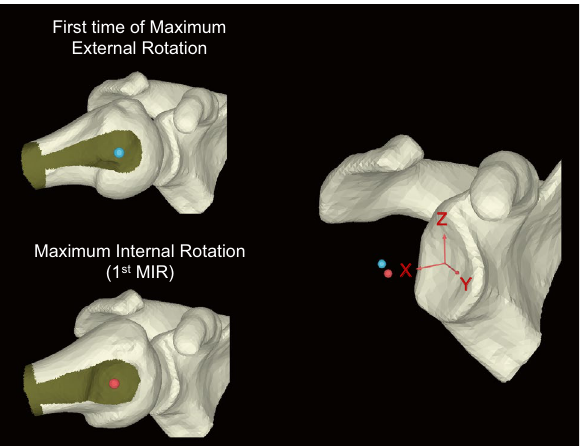
Figure 2. Coordinate system for the direction of translation of the joint contact area and humeral head centroid. Blue sphere; center of humeral head (CHH) at the original position, Red sphere; CHH at the first maximum internal rotation. The axes of the scapula coordinate system are aligned in the lateral/medial (X axis), anterior/posterior (Y axis), and superior/inferior (Z axis) directions.